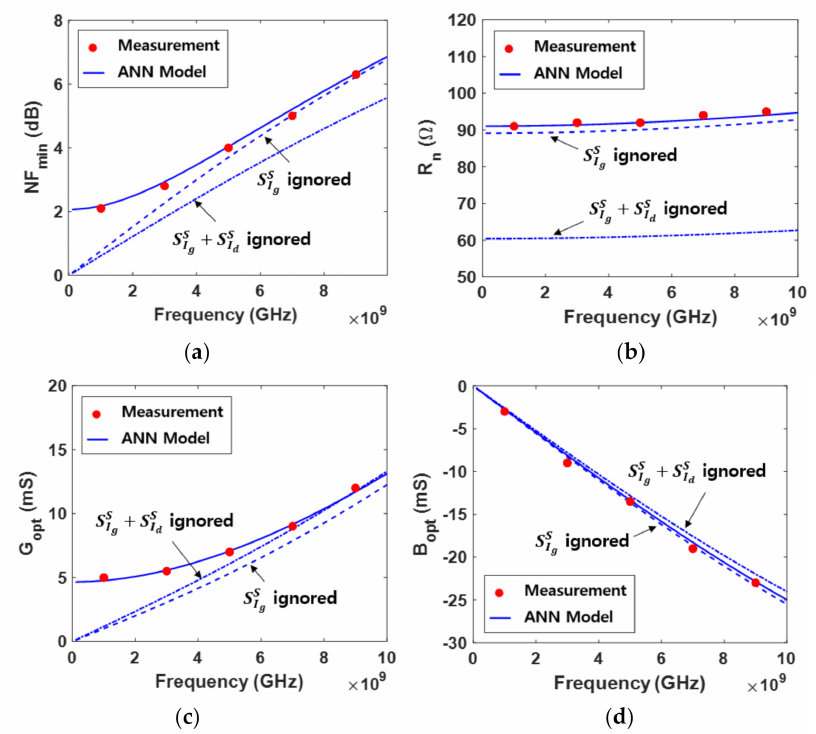
Figure 8. Comparison of the ANN-based model with measured data for the noise parameters at V gs = 1.0V, V ds = 0.5V for R g = 10 Ω , C gs = 50fF, and C gs = 30fF ( a ) the minimum noise figure NF min , ( b ) the noise resistance R n , ( c ) the optimum source conductance G opt , and ( d ) optimum source susceptance B opt